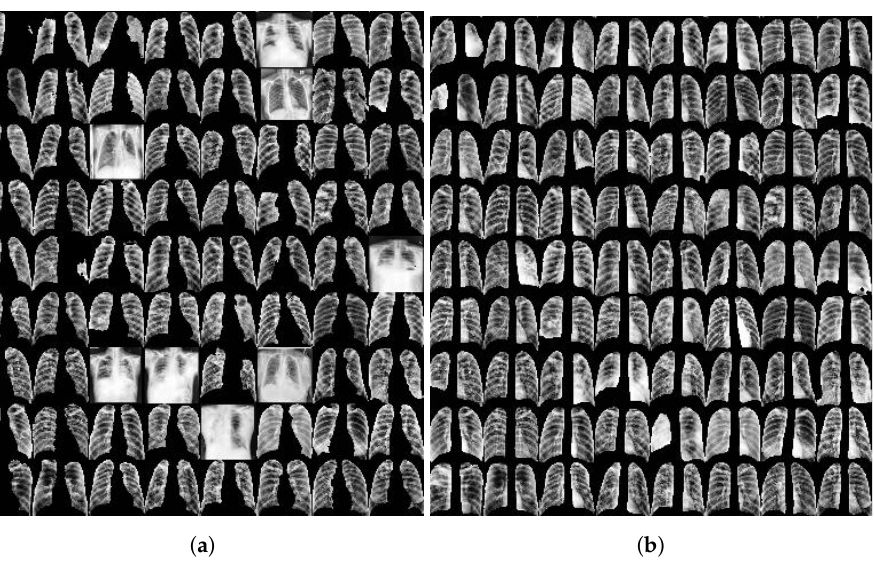
Figure 4. Cropped images based on the lung segmentation results obtained using a publicly available UNet model trained on the combined JSRT and Montgomery datasets ( a ), and using a customized UNet model trained on the v7 COVID-19 X-ray dataset ( b ). The performance of the customized model is clearly better. Note that if the segmentation fails, the entire image is